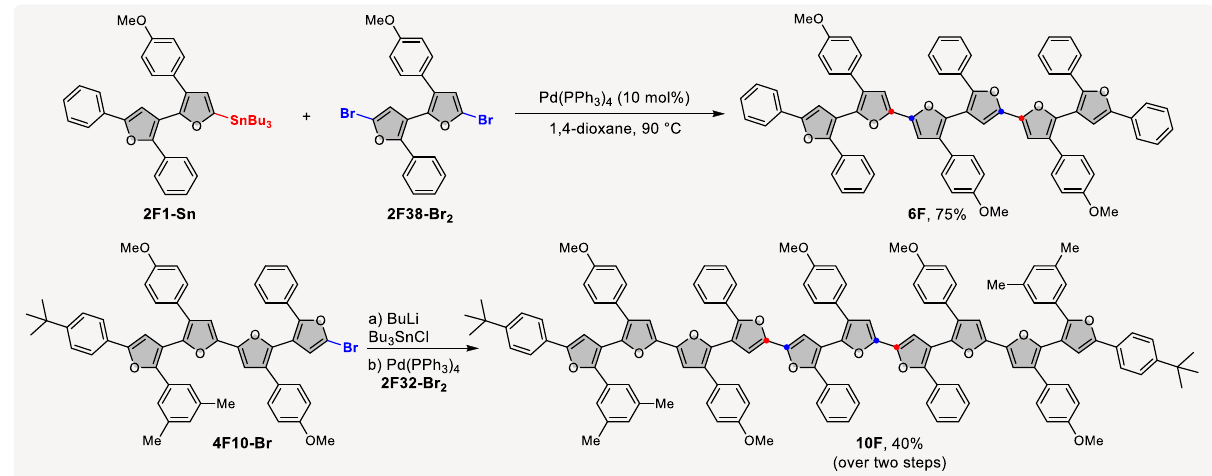
Fig. 6 Bottom-up synthesis of sexifuran and decafuran. Reaction conditions: please see pages 61 and 62 of Supplementary